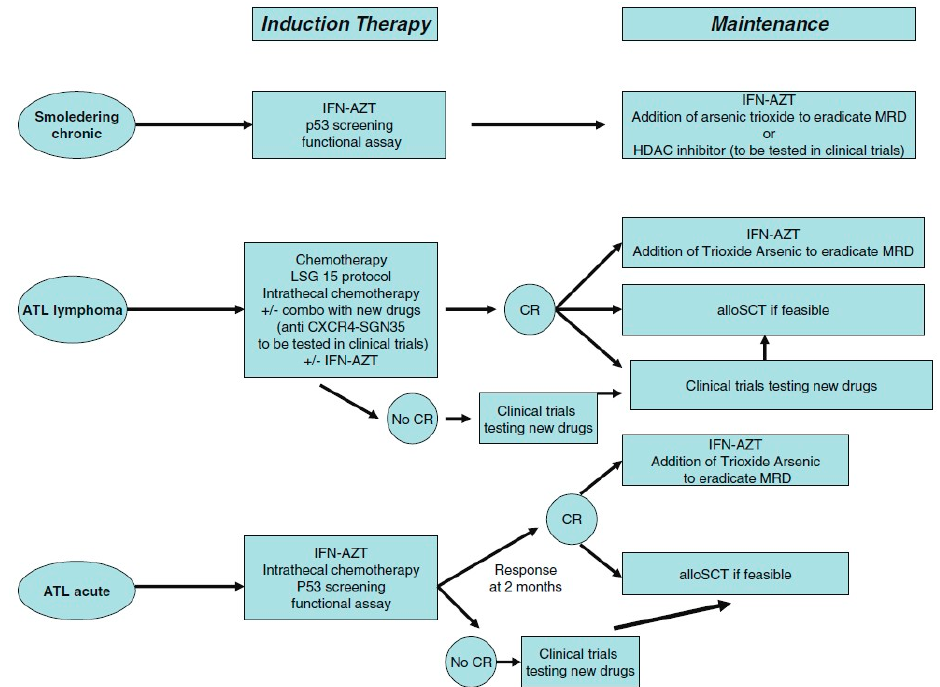
Figure 8. Recommended treatment strategy for patients with acute, lymphoma or chronic and smoldering subtypes of adult T-cell leukemia/lymphoma (ATL). CR: complete remission, MRD: minimal residual disease, AZT: zidovudine, IFN: interferon alpha, alloSCT: allogeneic stem cell transplantation, HDAC: histone deacetylase. Reproduced with permission from Marçais, A., Therapeutic options for adult T-Cell leukemia/lymphoma; published by Curr. Oncol. Rep. , 2013.